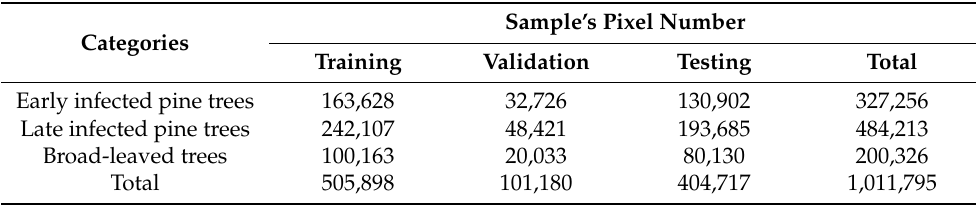
Figure 10. Training, validation, and testing samples of each tree category with the true labels. Table 3. Pixels of training, validation, and testing for each tree category.